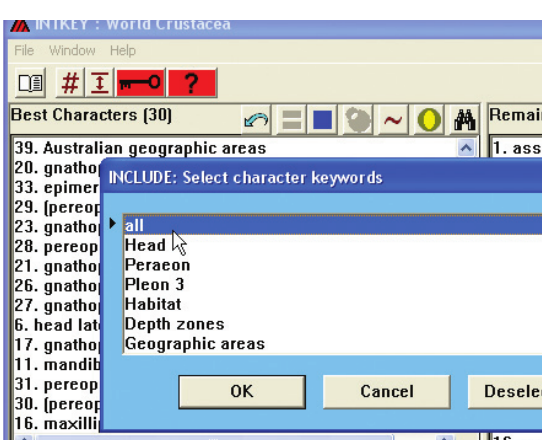
Figure 50. Use a subset of characters button.